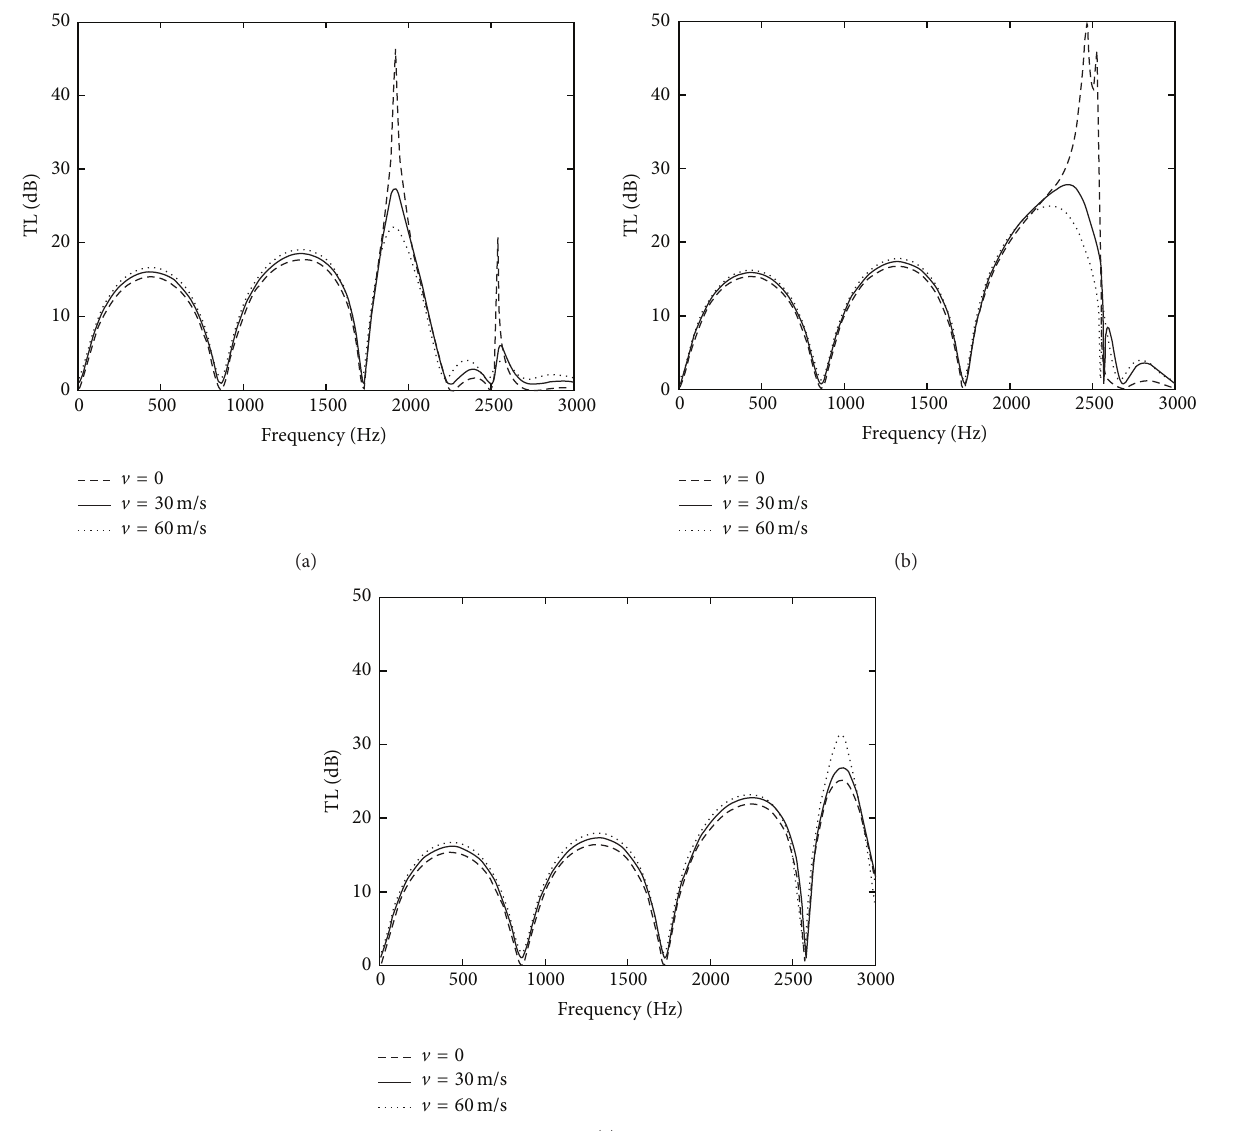
Figure 14: Effect of flow velocity on TL of the straight-through perforated pipe silencers: (a) silencer 𝑃 1 , (b) silencer 𝑃 2 , and (c) silencer 𝑃 3 .